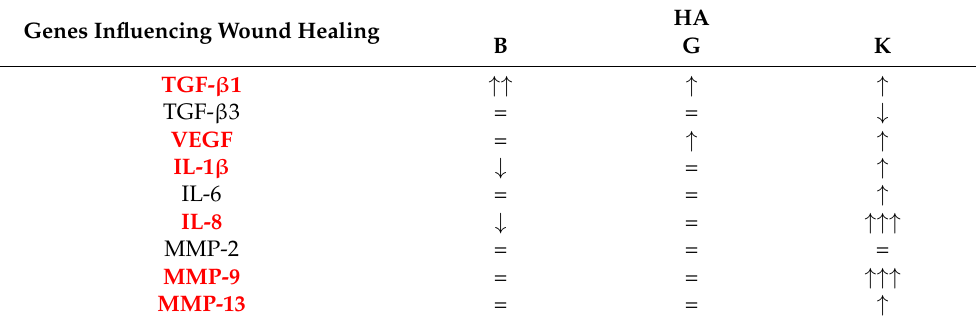
Table 3. Summary of the effect of HA-B, -G and -K on gene expression of HaCaT cells responsible for wound healing.